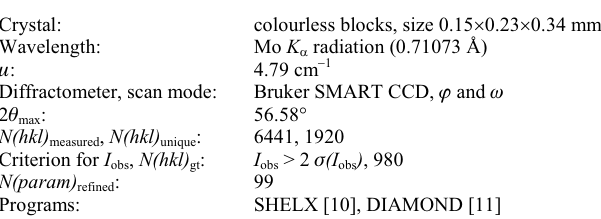
Table 2. Atomic coordinates and displacement parameters (in Å 2 )